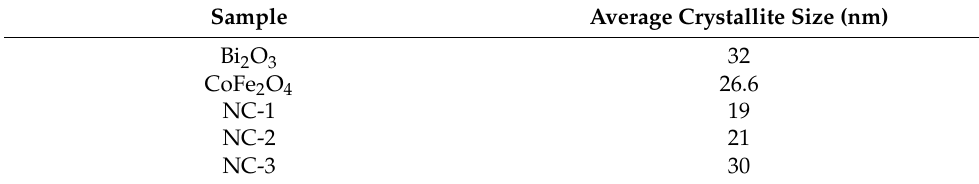
Figure 1. XRD patterns of ( a ) CoFe 2 O 4 [32]; ( b ) CoFe 2 O 4 (as-prepared); ( c ) NC-3; ( d ) NC-2; ( e ) NC-1; ( f ) Bi 2 O 3 (as-prepared); ( g ) Bi 2 O 3 [43]. Table 1. Crystallite size of prepared samples.